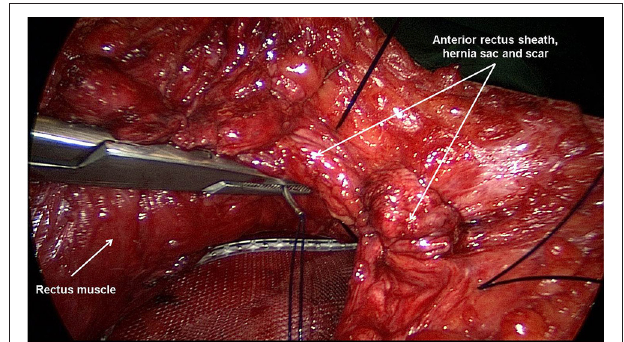
FIGURE 13 | Reconstruction of the linea alba by suturing together the anterior rectus sheath, hernia scar and the remaining hernia sac over the mesh.